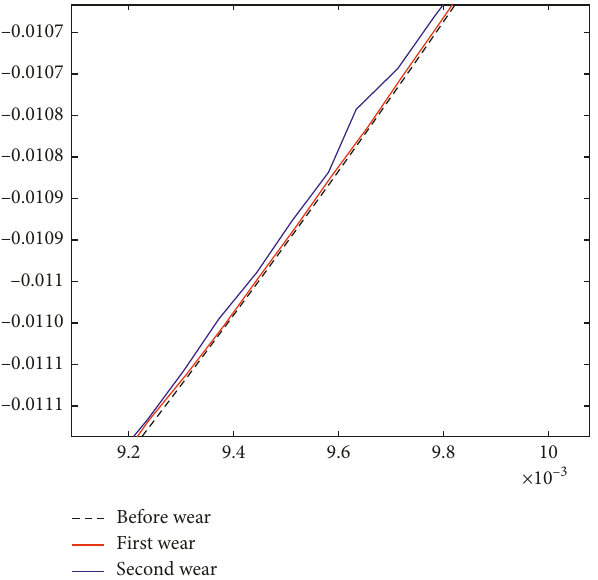
Figure 10: Bearing surface of joint B .